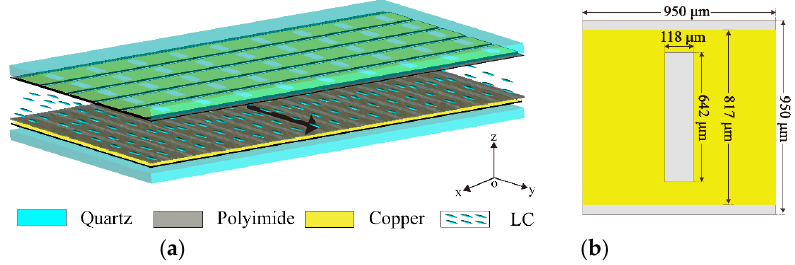
Figure 1. ( a ) Schematic of the liquid crystal (LC) based tunable phase shifter; ( b ) Geometrical dimensions of the unit cell structure.